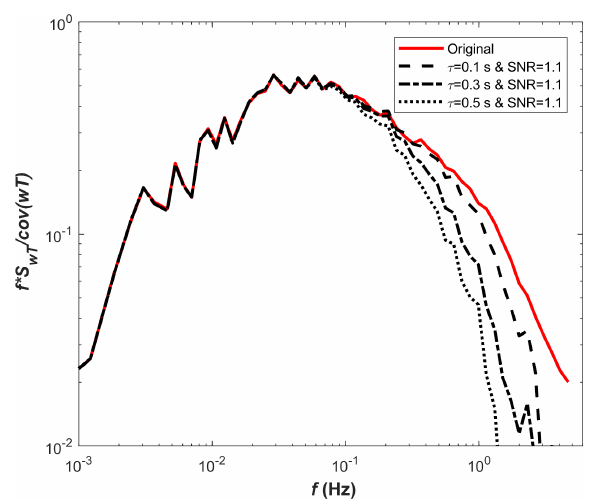
Figure 6. Normalized ensemble cospectra for the original and var- ious attenuated time series (i.e. τ =0.1, 0.3, and 0.5 s). White noise was added at a signal-to-noise ratio (SNR) of 1.1. The red line repre- sents the unattenuated and noise-free cospectrum, while the dashed, dotted-dashed, and dotted lines show the noise-contaminated and low-pass filtered cospectra for the three attenuation